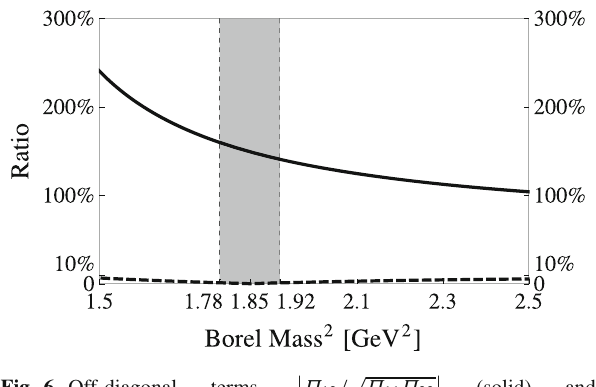
Fig. 6 Off-diagonal terms, (cid:15) (cid:15) (cid:16) (cid:15) (cid:15) / Π (cid:2) Π (cid:2) (cid:15) (dashed), as functions of the Borel mass M (cid:15) Π (cid:2) 13 11 33 These curves are obtained by setting s 0 = 11 . 0 GeV 2